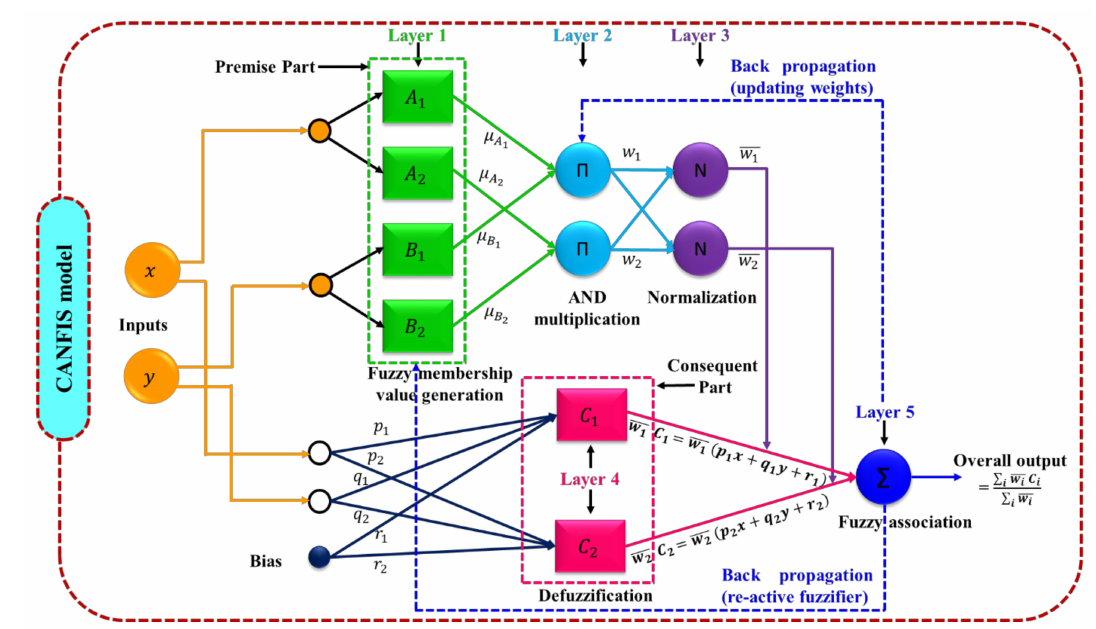
Figure 2. The architecture of the co-active neuro-fuzzy inference system (CANFIS) model.